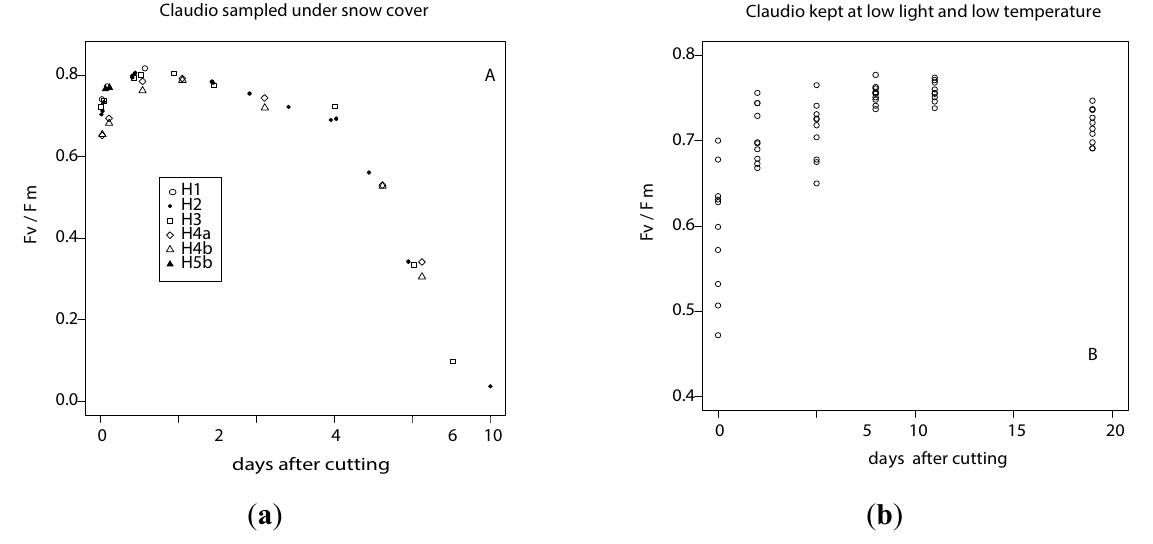
Figure 3. ( a ) Time course of F v /F m of leaves of the durum wheat variety Claudio cut in the field when plants were under snow cover and kept in the dark. Different symbols denote harvests in January/February 2012 at different times (H1, H2, H3, H4a, H4b, H5b). H4a leaves under snow cover, H4b from a plot with snow removed the day before cutting, H5b after snow melt; ( b ) Time course of F v /F m of leaves of the durum wheat variety Claudio cut in the field when plants where under snow cover (10 February 2013) and kept in the light at low temperature